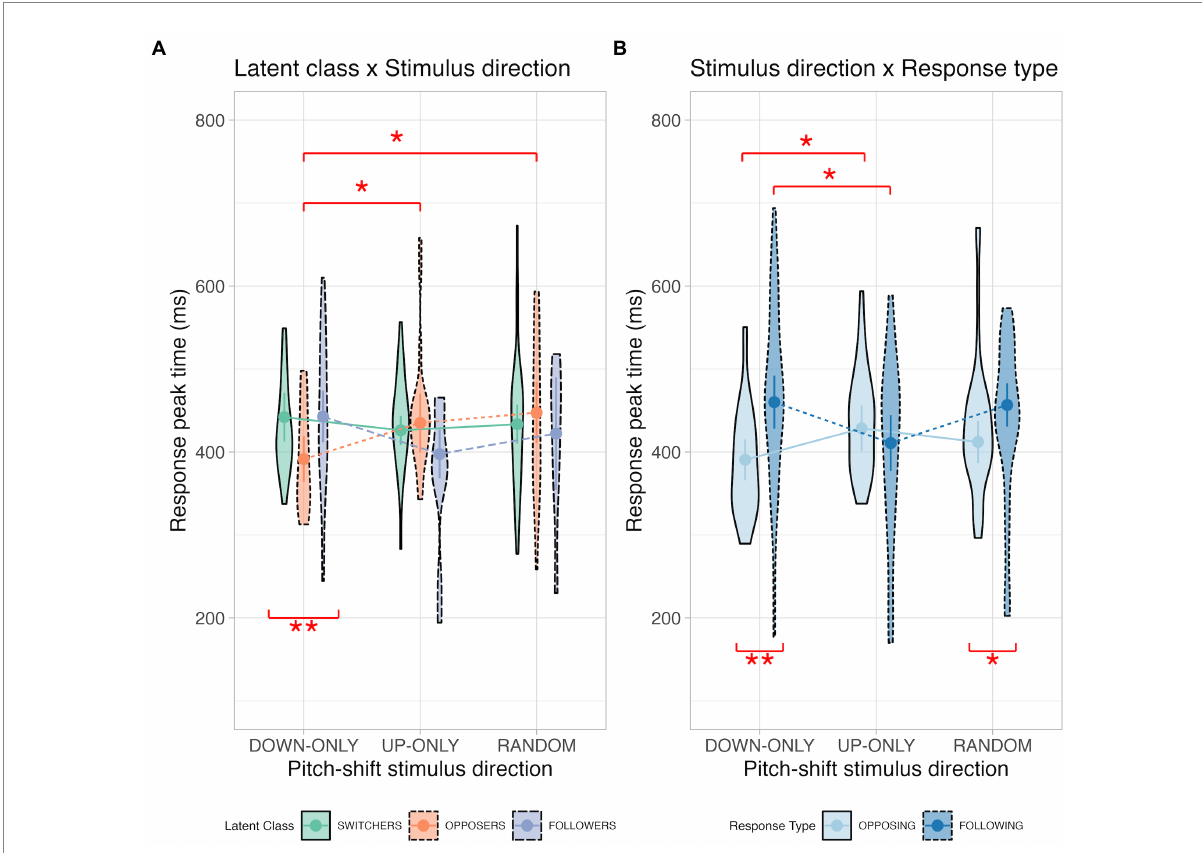
FIGURE 4 Violin plots illustrating the latent class × stimulus direction interaction (Panel A ) and the stimulus direction × response type interaction (Panel B ) for the response peak time. Definitions for the violin plots: Means superimposed with error bars are connected by lines, violin shapes extend to 1.5 times the interquartile range, and widths of the violin shapes represent density